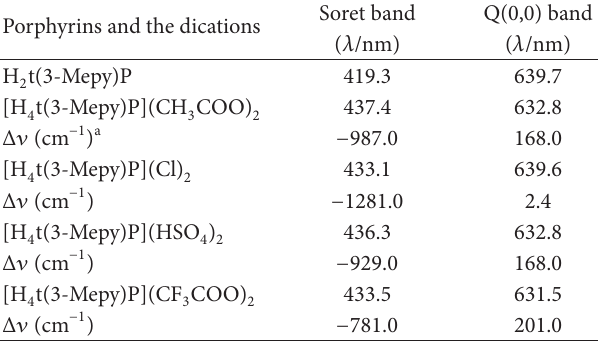
82.7 for details). 2.4 t(3-Mepy)P with 2